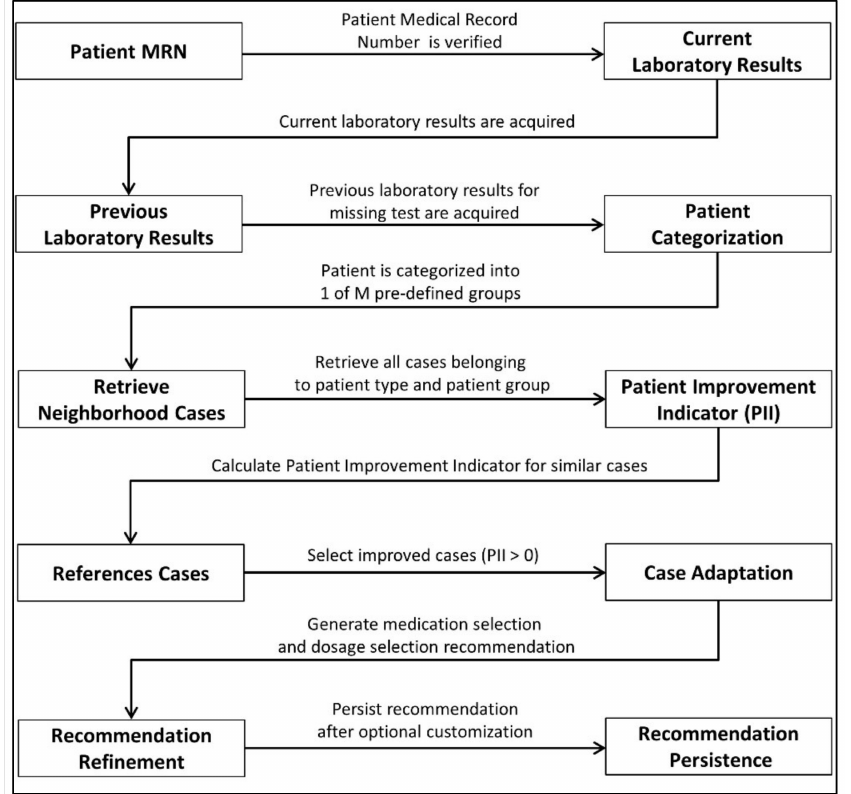
Figure 10. Process flow for CKD–MBD CDSS pertaining to the treatment regimen